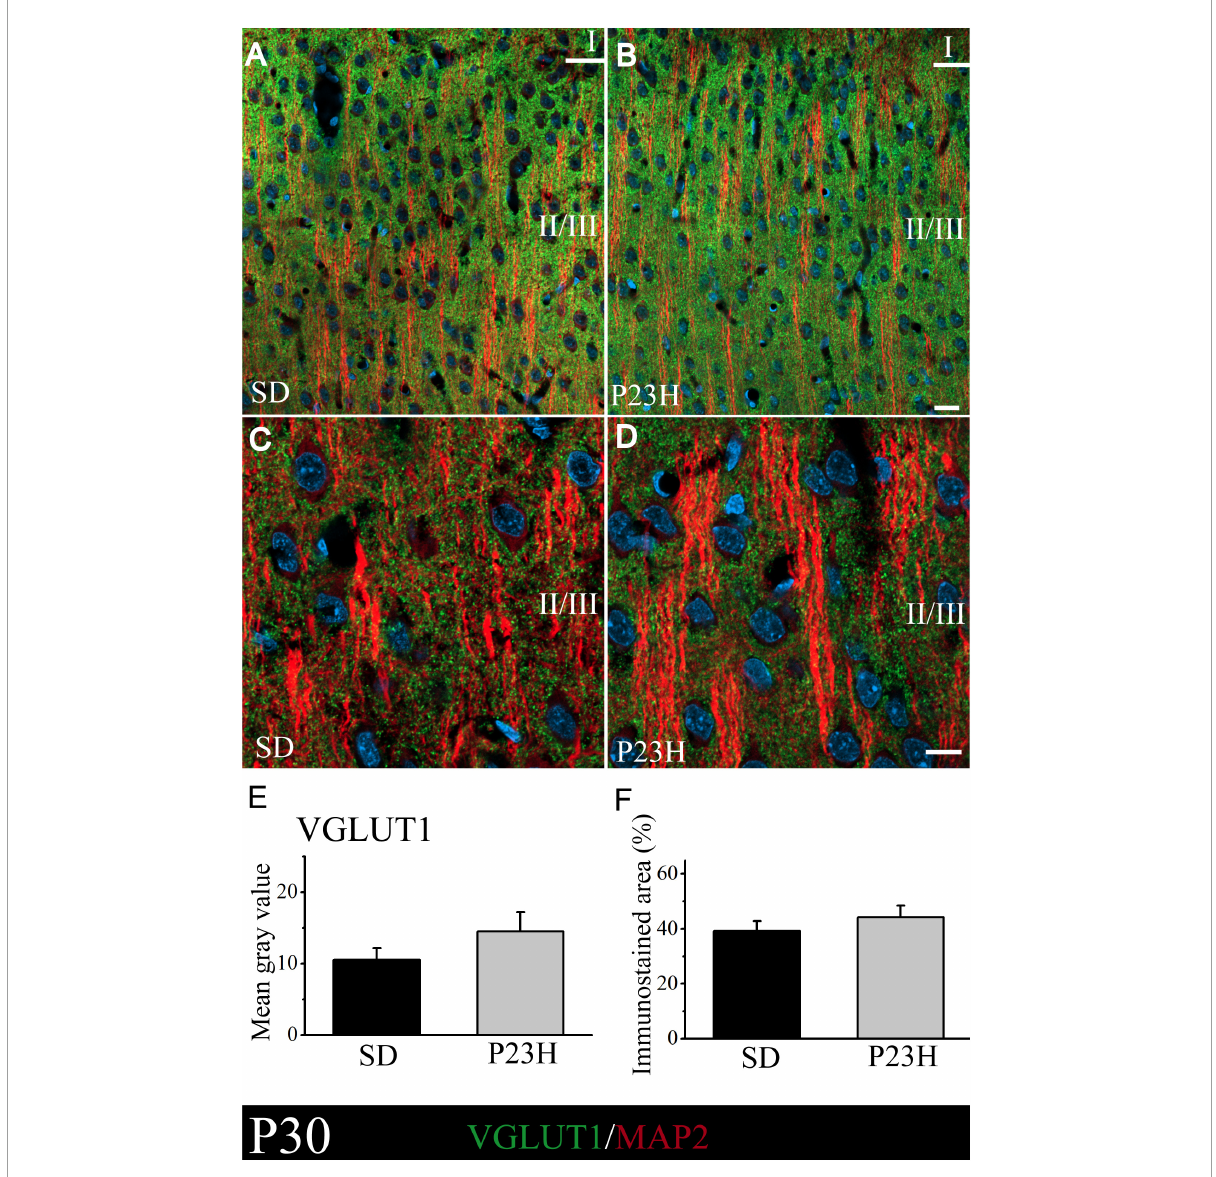
FIGURE2 VGLUT1 and MAP2 immunolabeling in the visual cortices of the SD and P23H rats at P30. (A,B) Confocal images of the VGLUT1-ir presynaptic structures (green) and MAP2-ir somata and dendrites (red) along the supragranular layers of the visual cortices of the young SD and P23H rats. Nuclei are counterstained with DAPI (blue). (C,D) High-magnification confocal images of VGLUT1 and MAP2 immunolabeling of visual cortical layers II/III. VGLUT1-ir terminals are homogeneously distributed and the amount of VGLUT1 seems similar for both conditions. (E,F) Quantification of the MGV and % of immunostained areas. No statistically significant differences were found. Scale bar: 20 µ m.